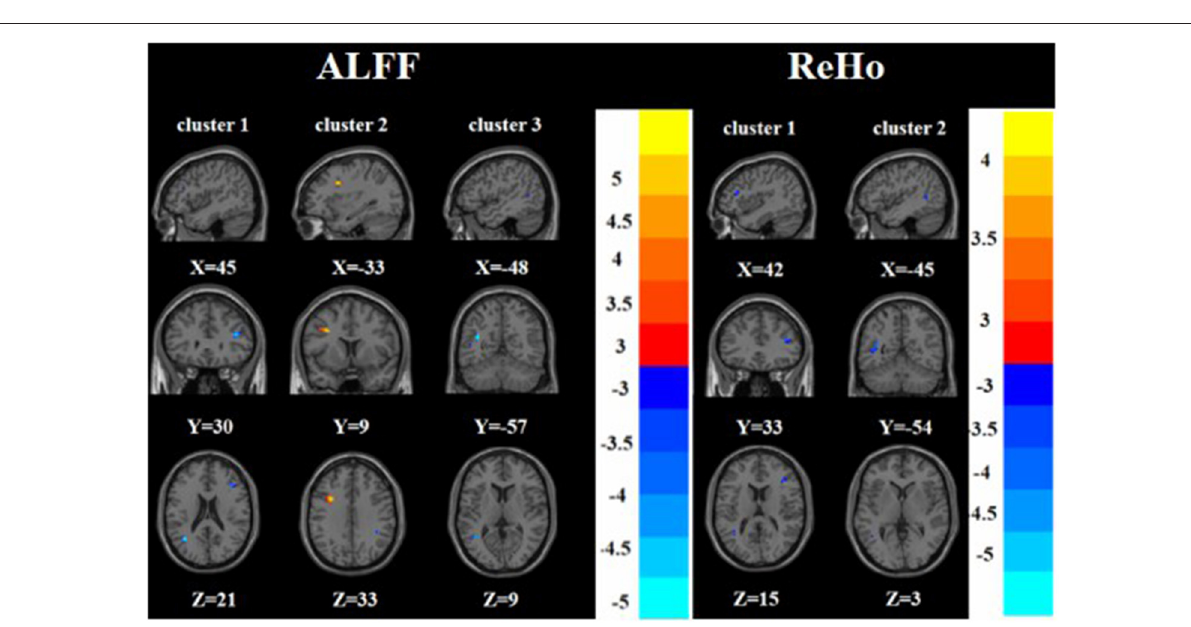
FIGURE 4 | Brain regions with abnormal ALFF (left) and ReHo (right) between TRD group and HC group based on post hoc T -tests. The color bars indicate the T